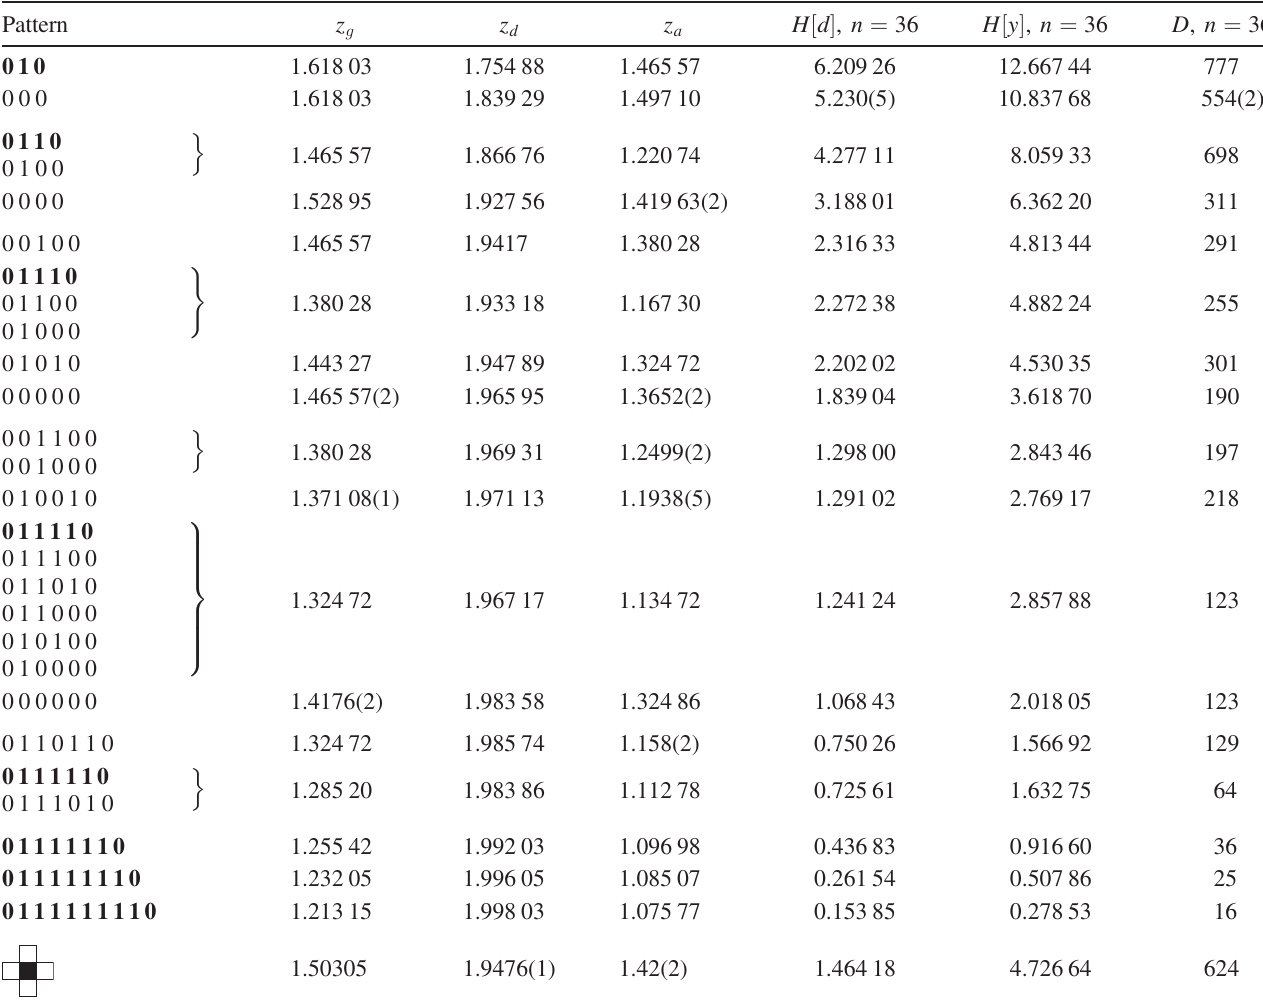
TABLE I. Values of the numbers z , z , and z for different filters. These give the asymptotics of, respectively, the total number of g d a n Þ ≅ z n , the largest degeneracy d , and the number of outputs with degeneracy one, N ð 1 ; n Þ ≅ z n outputs M ð n Þ ≅ z n g D ð d final row corresponds to a simple filter, as illustrated, applied to 2D input (see also Fig. 2). Note that we also included filter patterns consisting of all zeros. For each filter we also give the relevance H ½ d (cid:2) calculated from the degeneracy distribution and the resolution H ½ y (cid:2) for inputs of size n ¼ 36 . For the sake of comparison, the standard entropy of the inputs of this size is H ¼ 36 ln 2 ¼ 24 . 95330 . Finally, we include the number of distinct degeneracies D for each pattern. The boldface font patterns indicate a subset of filters that we discuss specifically in the main